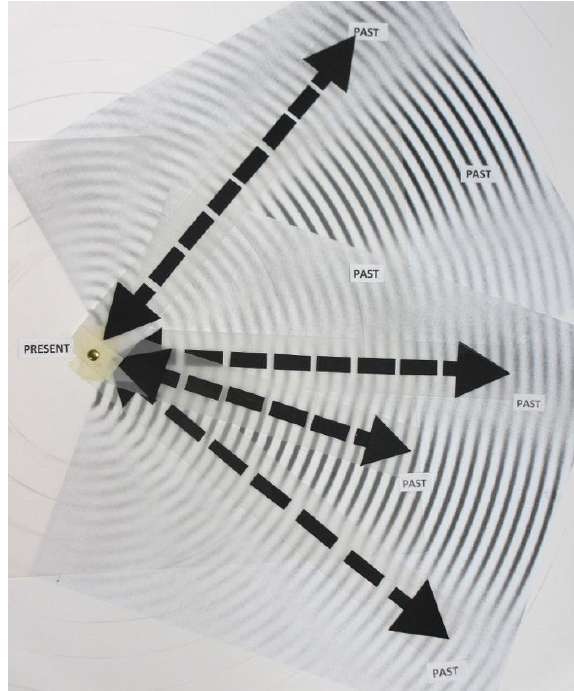
Figure 4. The Ripple Effect. Rachel Matthews 2018. Example of a visual teaching resource used to depict how our understanding of history can be changed, interrupted and adjusted by the present. The dotted lines, ripples and double-headed arrows convey the notion of a dialogue between the past and the present, that is rarely direct or continuous.